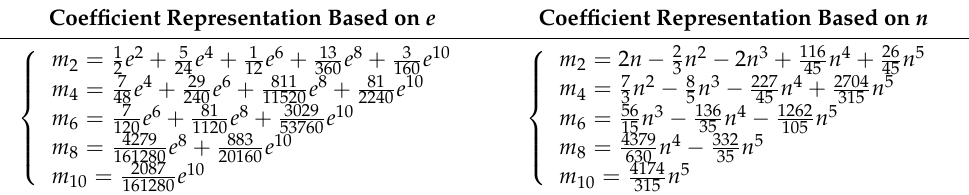
Table 3. Coefficients in Equation